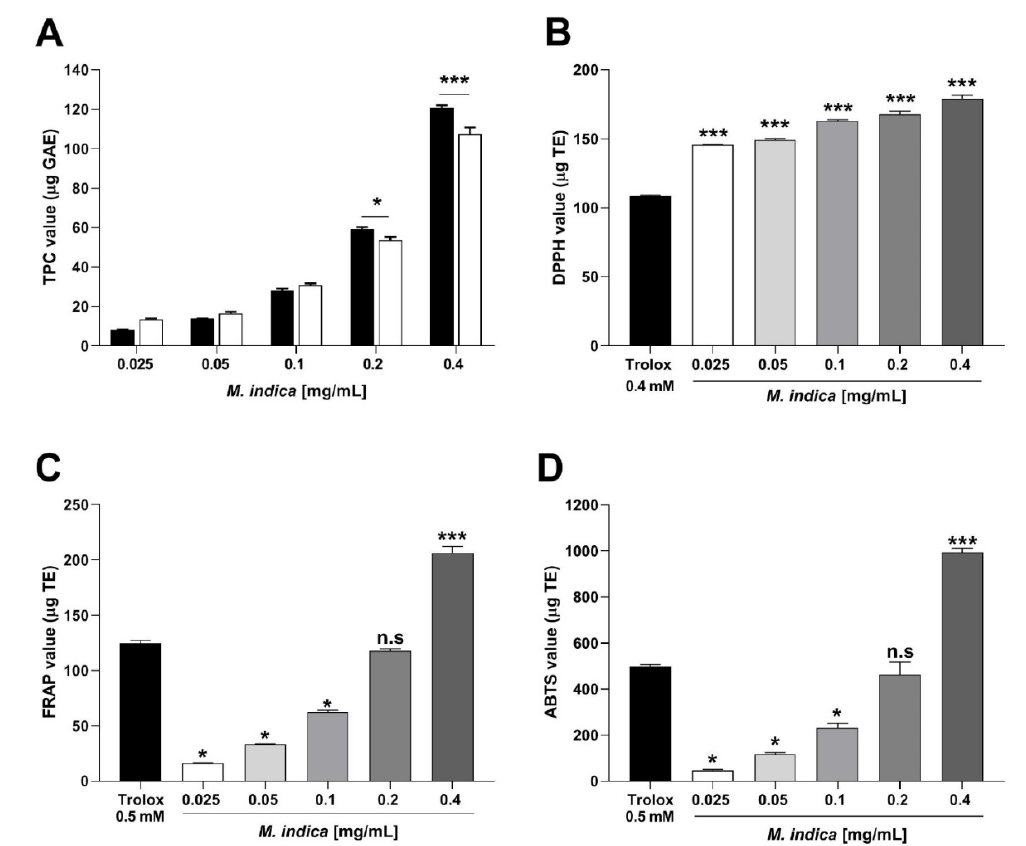
Figure 2. Total phenolic content (TPC) ( A ) and antioxidant activity of lyophilized extract of M. indica (MIE) by DPPH ( B ), FRAP ( C ), ABTS ( D ) assays. Panel ( A ), TPC was determined in an aqueous (black bar) and ethanolic (white bar) solution, while panels ( B – D ) show the aqueous solution of MIE. Panel ( A ) shows the data are expressed in micrograms of gallic acid equivalents ( µ g GAE), while, in panels ( B – D ), the data are expressed in micrograms of Trolox equivalents ( µ g TE). Each bar represents the mean ± the standard error of the mean (SEM) of three experiments ( n = 3). n.s = not significant, statistical di ff erences: * p < 0.05, *** p < 0.001 vs. black bar.